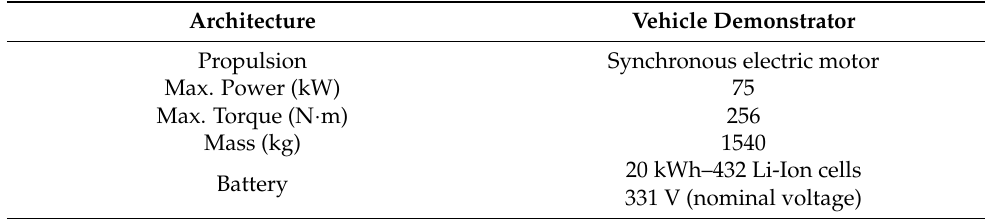
Table 1. Test vehicle characteristics